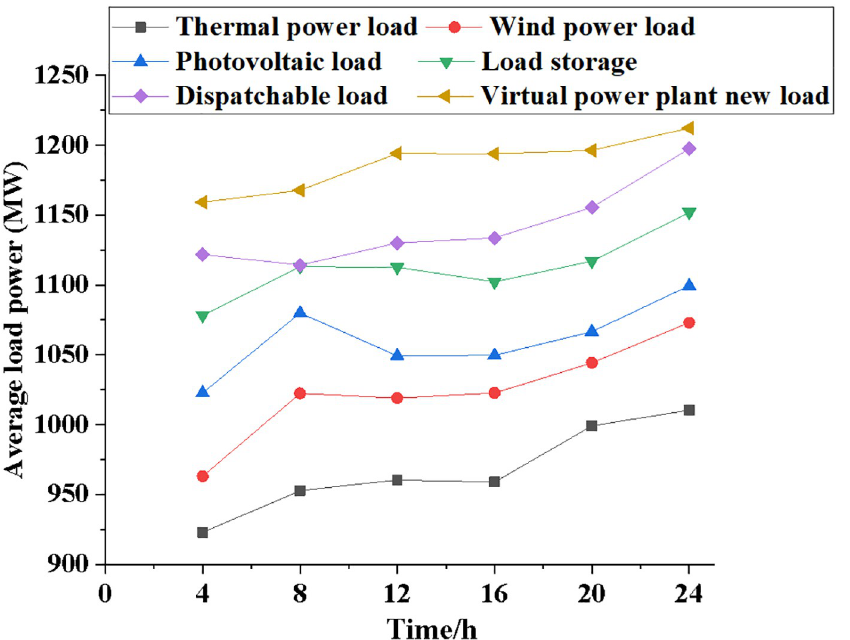
Fig 6. Change and comparison of average load power of different electric load